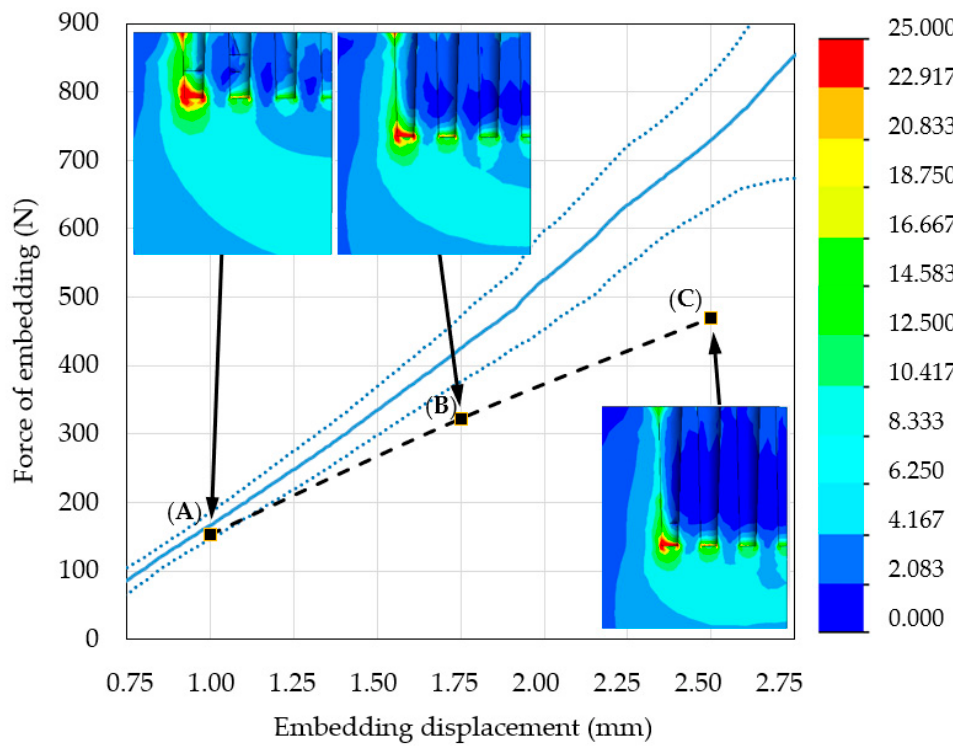
Figure 9. Region II of the force–distance curves obtained from experimental measurements (the mean line is presented as the solid blue line, dotted blue lines are ± standard deviations) and from numerical simulations. The dashed black line represents results of numerical simulation of the problem. The insets show representative maps of the Huber–von Mises–Hencky (HMH) stress distributions calculated for the considered system containing the MSC-Scaffold prototype and periarticular bone material with the embedding load applied to the top surface of the MSC-Scaffold prototype. (A) 1 mm embedding displacement and 153 N force of embedding; (B) 1.75 mm embedding displacement and 322 N force of embedding; (C) 2.5 mm embedding displacement and 469 N force of embedding.